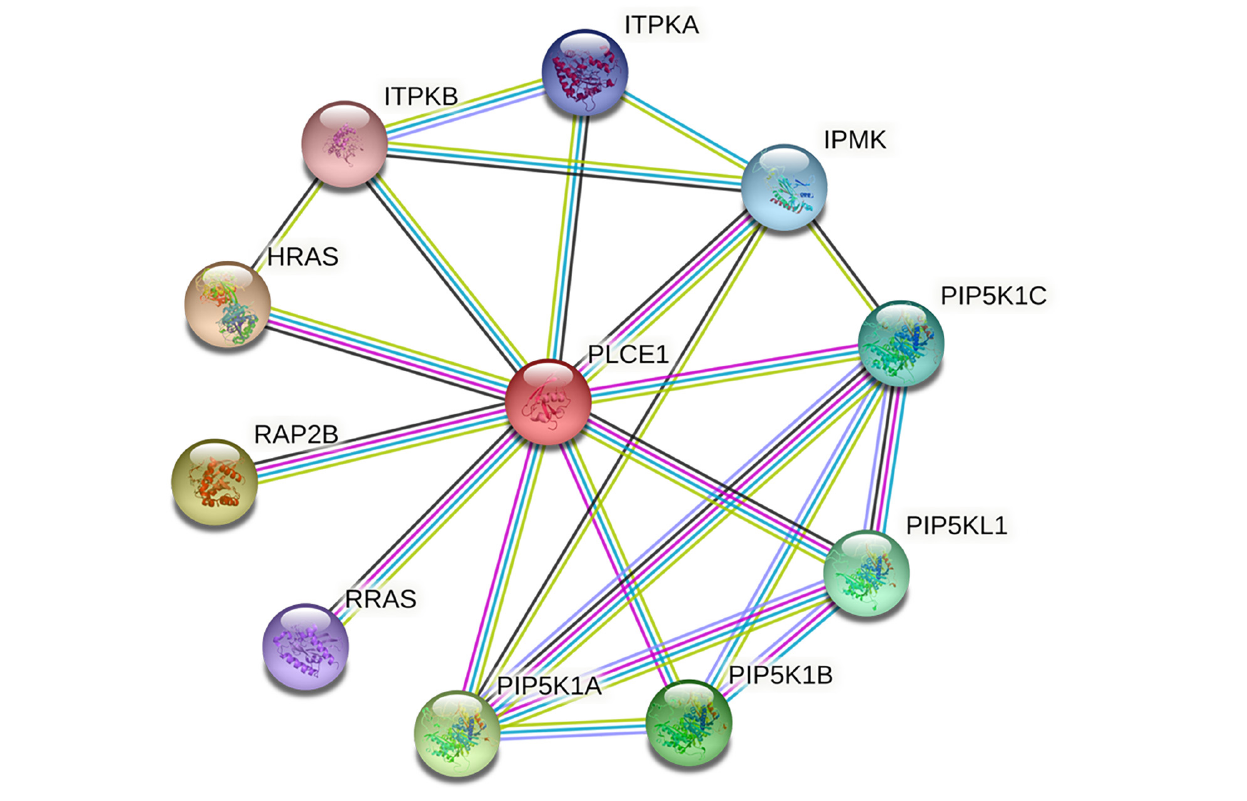
FIGURE 2 | The core protein-protein interaction (PPI) network of PLCE1 constructed by STRING database. It was consisted by 11 nodes and 22 edges with the average node degree of 4 in gastric cancer. The nodes represent proteins; the edges represent interactions between proteins in the network. PLCE1, 1-phosphatidylinositol 4, 5-bisphosphate phosphodiesterase epsilon-1; HRAS, GTPase Hras; ITPKB, inositol-trisphosphate 3-kinase B; ITPKA, inositol-trisphosphate 3-kinase A; IPMK, inositol polyphosphate multikinase; PIP5K1C, phosphatidylinositol 4-phosphate 5-kinase type-1 gamma; PIP5KL1, phosphatidylinositol 4-phosphate 5-kinase-like protein 1; PIP5K1B, phosphatidylinositol 4-phosphate 5-kinase type-1 beta; PIP5K1A, phosphatidylinositol 4-phosphate 5-kinase type-1 alpha; RRAS, Ras-related protein R-Ras; RAP2B, Ras-related protein